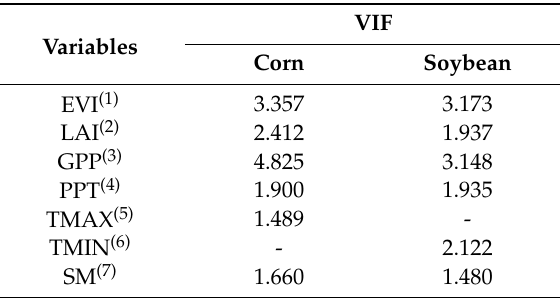
Table 2. Variation inflation factors (VIFs) of selected variables (May to September) against corn and soybean yields, 2006–2015.